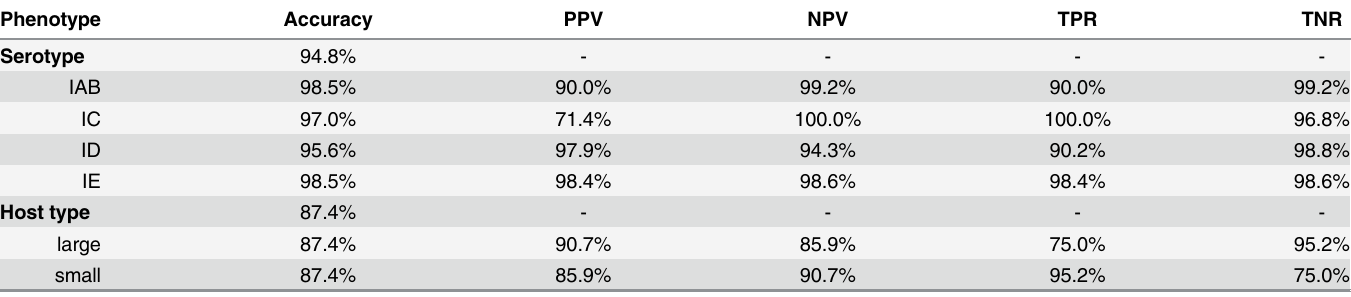
Table 3. Accuracy, positive (PPV) and negative predictive value (NPV), true positive (TPR) and negative (TNR) rates for serotype and host type